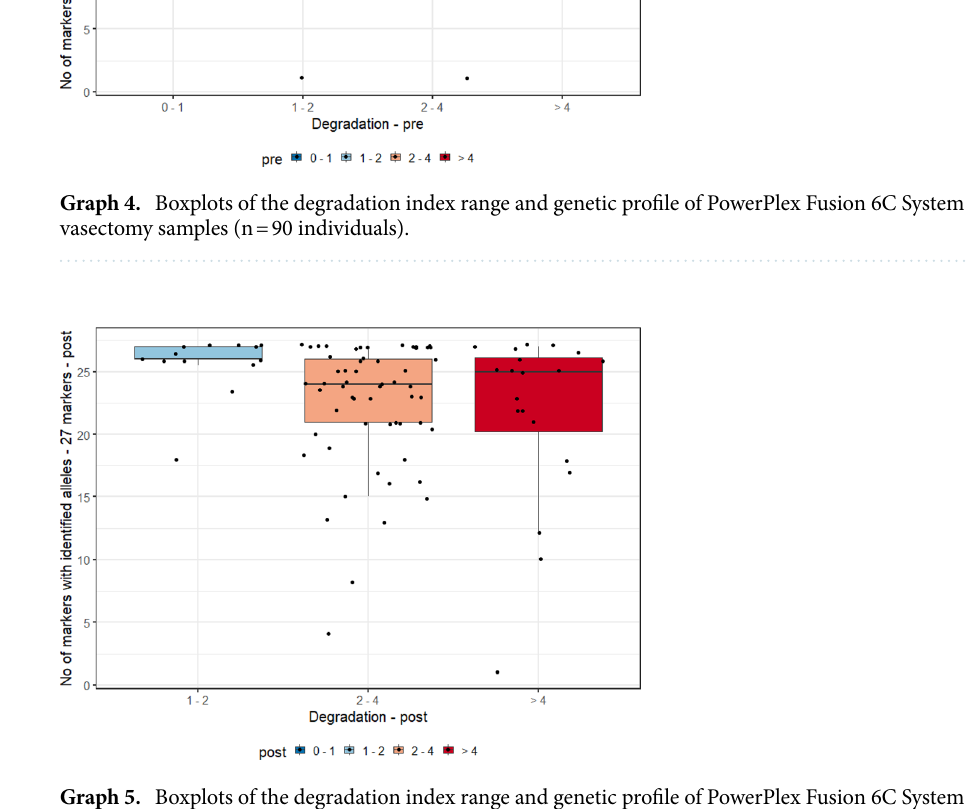
Graph 5. Boxplots of the degradation index range and genetic profile of PowerPlex Fusion 6C System of post- vasectomy samples (n = 90